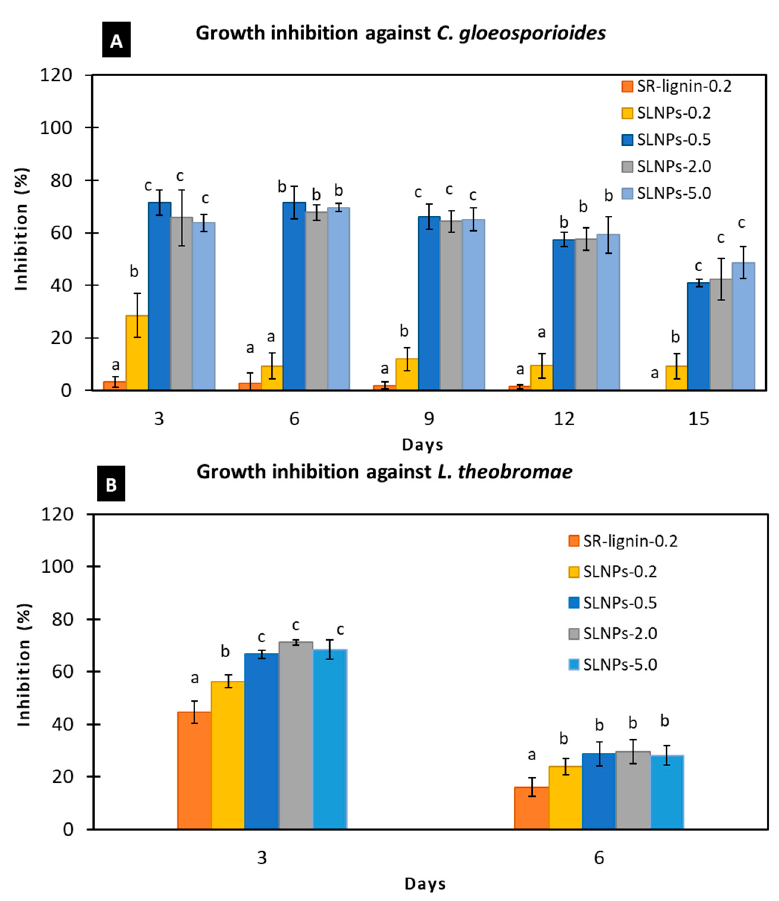
Figure 5. Antimicrobial effects of raw softwood kraft lignin (SR–lignin) and SLNPs in PDA against ( A ) Colletotrichum gloeosporioides and ( B ) Lasiodiplodia theobromae . Values are presented as mean ( n = 3) with the standard deviation represented by vertical bars. Means followed by the same letter between treatments per day are not significantly different at p ≤ 0.05 using DMRT. SR–lignin: raw softwood kraft lignin.